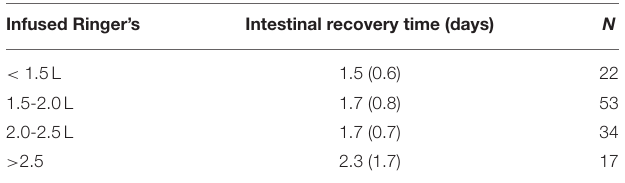
TABLE 6 | Prolongation of the postoperative recovery time for increasing volumes of infused crystalloid fluid.